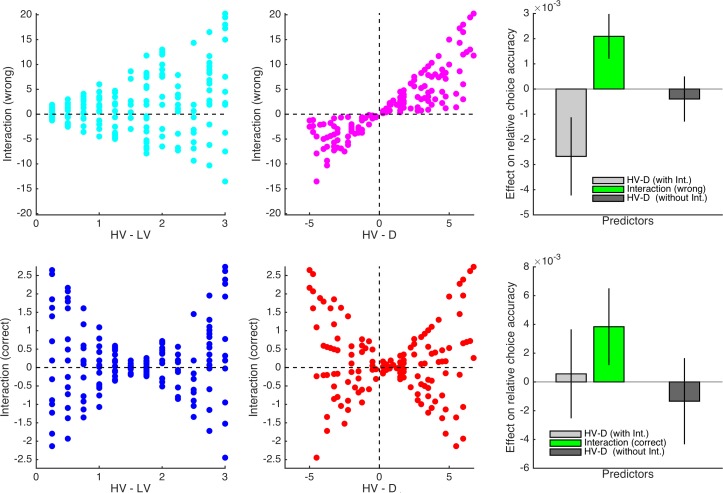
The influence of the interaction term (HV-LV)×(HV-D) on the estimation of the HV-D effect.The upper row refers to the incorrect interaction term that is generated based on uncentered HV-LV and HV-D; the lower row refers to the correct interaction term that is generated based on standardized HV-LV and HV-D. The first two columns show correlations between the interaction terms and HV-LV/HV D, respectively. The last column shows the mean regression coefficients of 1’000 simulations of 21 decision makers whose choices depend only on HV-LV. Only when the incorrect interaction term is included is the HV-D coefficient biased in the negative direction. Note that both incorrect and correct interaction terms are estimated to be positive, which is another statistical artifact and results from the positive correlation between the predictors HV-LV and HV-D (r = .138; simulations with uncorrelated HV-D and HV-LV predictors do not exhibit this statistical artifact).